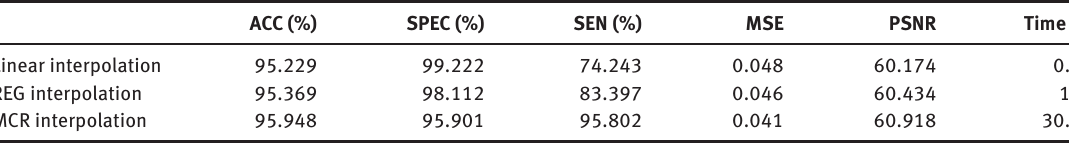
Table 3: Average performance analysis for interpolation involving 100 slices.